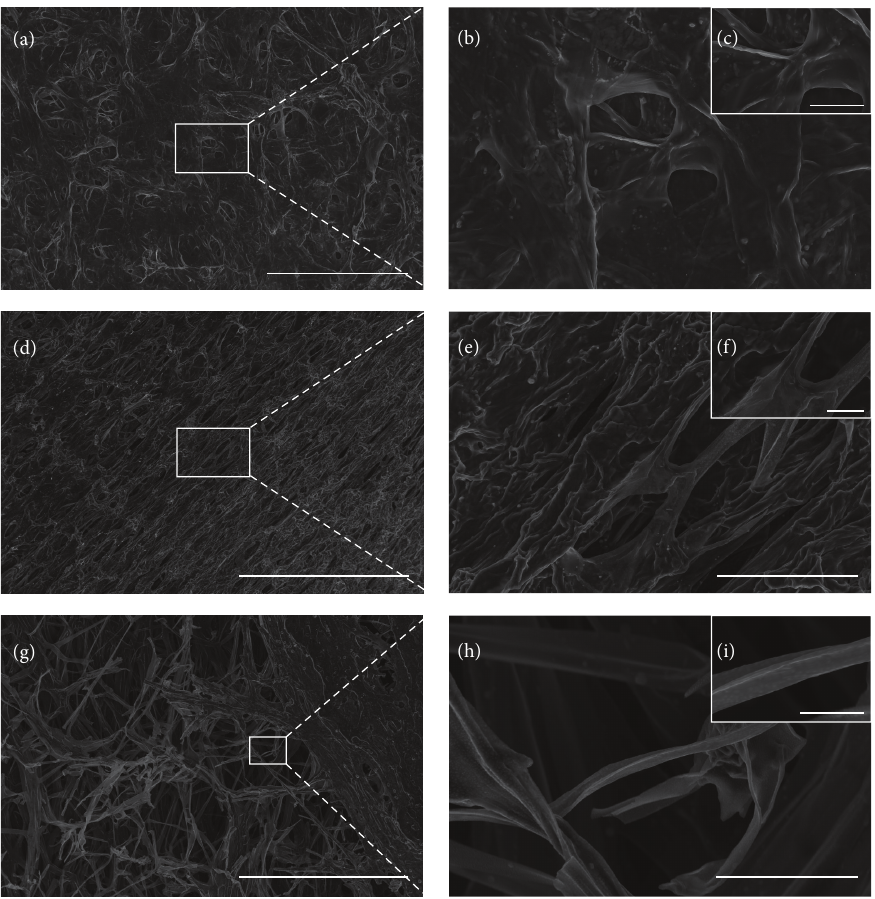
Figure 2: SEM micrographs, low to high magnification, of CT (a–c) (scale bars = 200 𝜇 m, 40 𝜇 m, and 10 𝜇 m), ST (d–f) (scale bars = 400 𝜇 m, 50 𝜇 m, and 10 𝜇 m), and CST (g–i) (scale bars = 300 𝜇 m, 20 𝜇 m, and 4 𝜇 m).